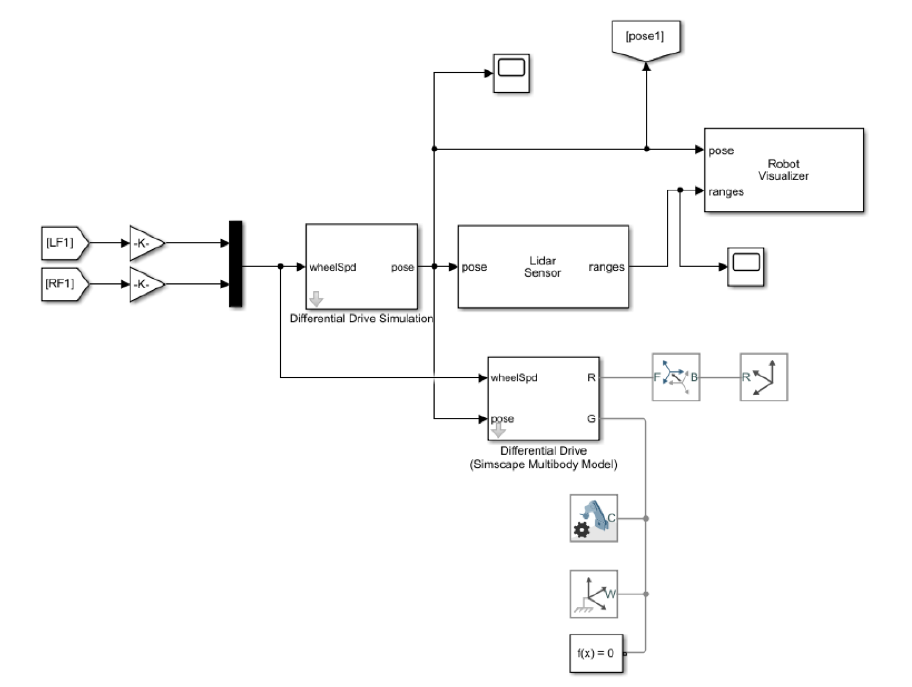
Fig. 4. A model of a differential robot with Mobile Robotics Simulation Toolbox